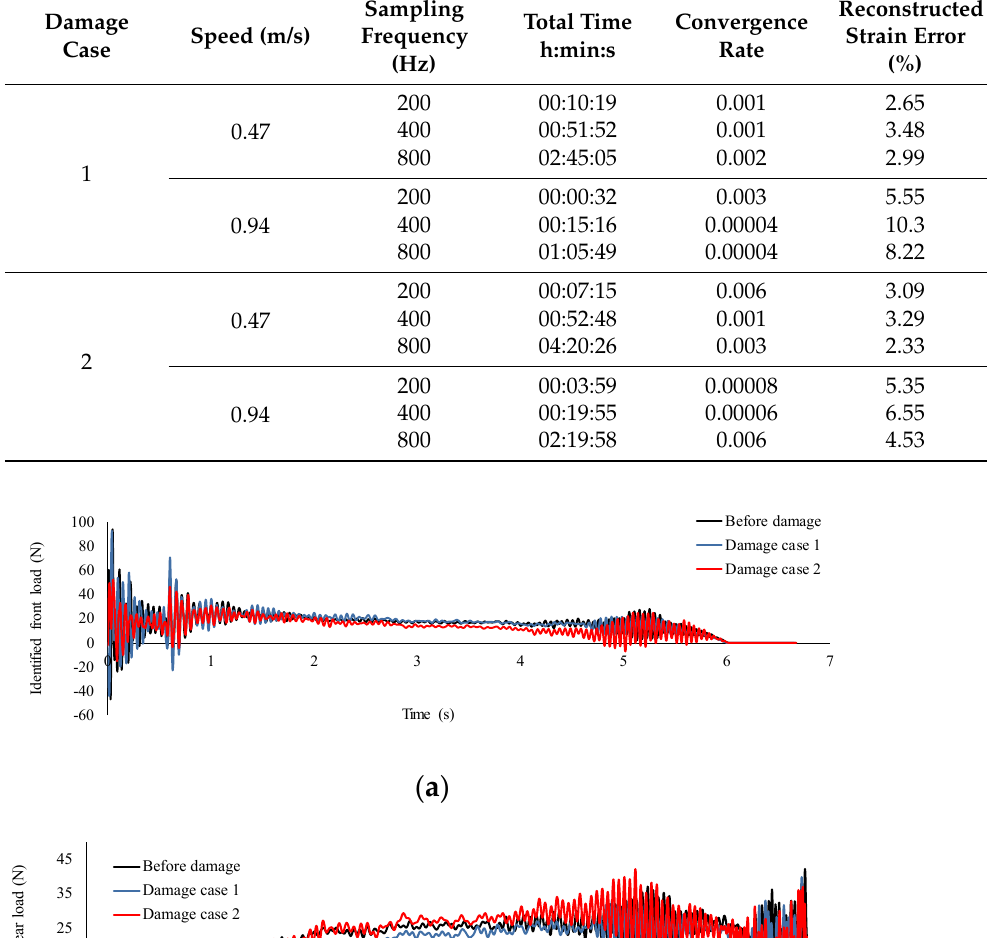
Table 12. Damage identification results from the simultaneous identification.